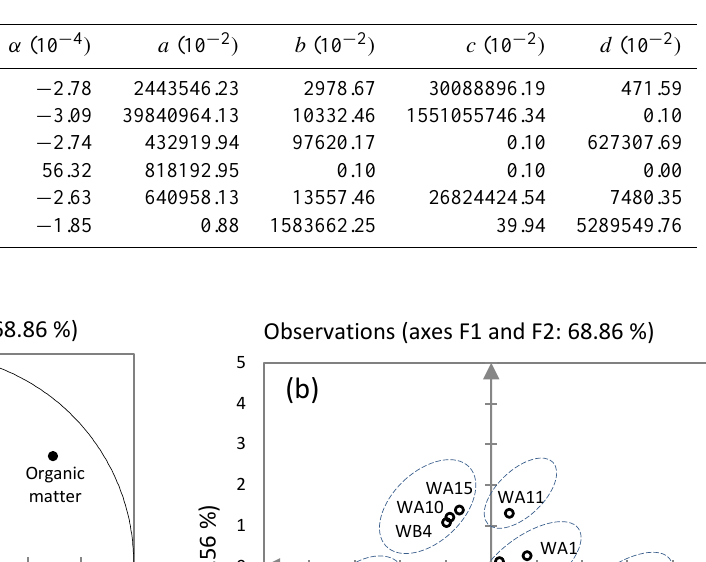
Table 3. Factor parameters obtained for the different clusters (cf. Eq. 4). k 0 = reaction rate at reference temperature T 0 (T − 1 ), 1E = activation energy (Jmol − 1 ), α = parameter describing soil moisture dependency (T − 1 ), a = cluster constant, b = root biomass factor, c = litter layer factor, d = organic matter factor.